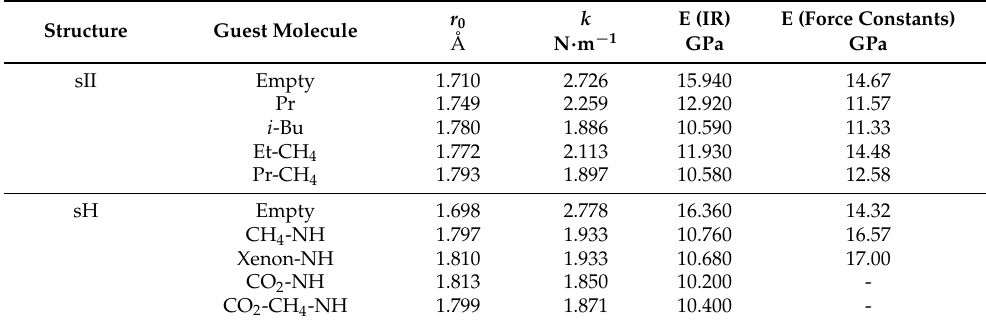
Table 3. Equilibrium Hydrogen Bond Length, Force Constants, and Young’s Moduli for sII [24,76] and sH [30,77] Gas Hydrate